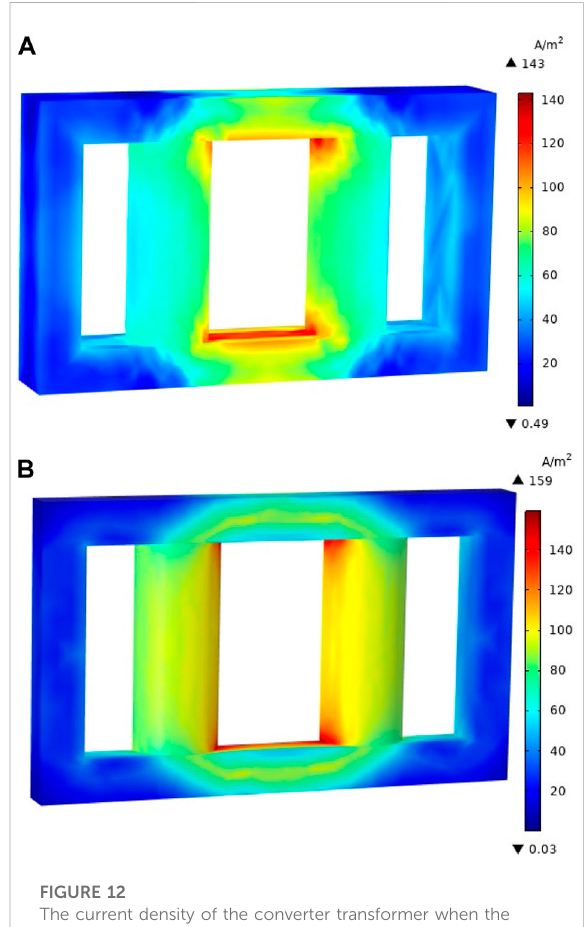
FIGURE 12 The current density of the converter transformer when the load rate of the converter transformer is 60% and 100%: (A) 60% load rate; (B) 100% load rate.